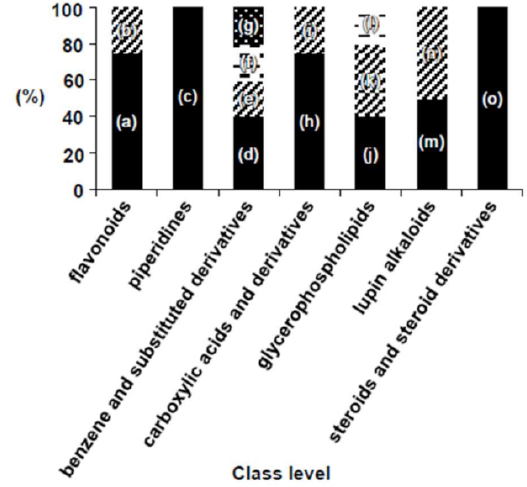
Figure 3. Bar plot of organic compounds annotated in Chinese chives. Each bars of seven class levels consist of one or more subclass levels. (a) flavonoid glycosides; (b) flavans; (c) phenylpiperidines; (d) benzyl alcohols; (e) benzoic acids and derivatives; (f) diphenylmethanes; (g) sulfanilides; (h) amino acids and derivatives; (i) peptides; (j) glycerophosphocholines; (k) glycerophosphoethanolamines; (l) glycerophosphoinositols; (m) cytisine and derivatives; (n) matrine alkaloids; (o) ergosterols and